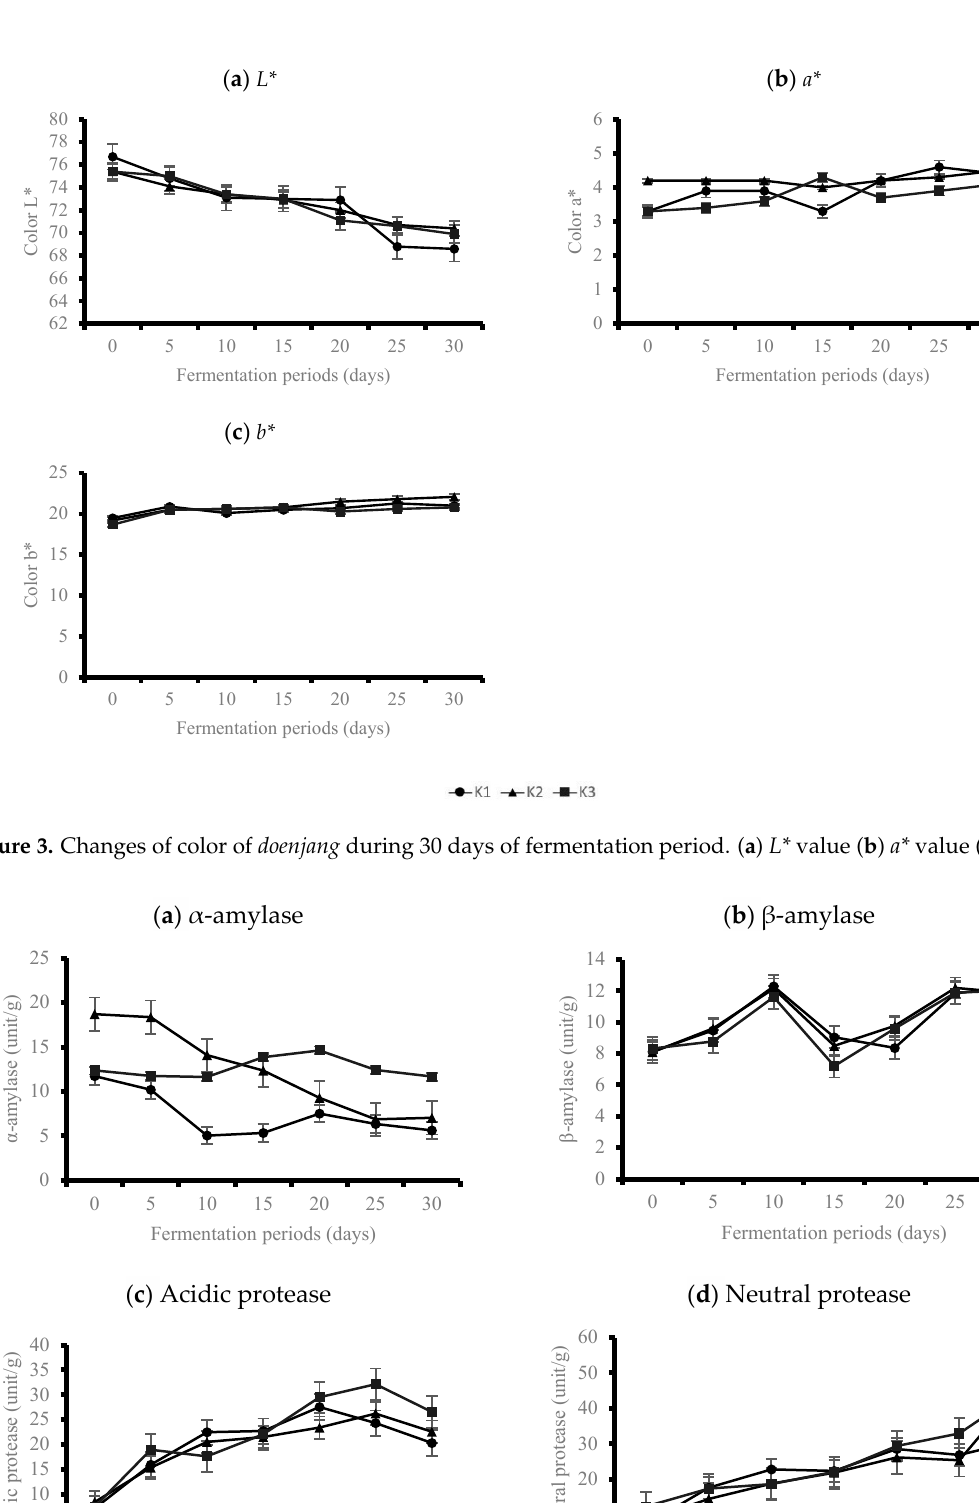
Figure 4. Changes of enzymatic activities of doenjang during 30 days of fermentation period. ( a ) α -amylase, ( b ) β -amylase, ( c ) Acidic protease, ( d ) Neutral protease.